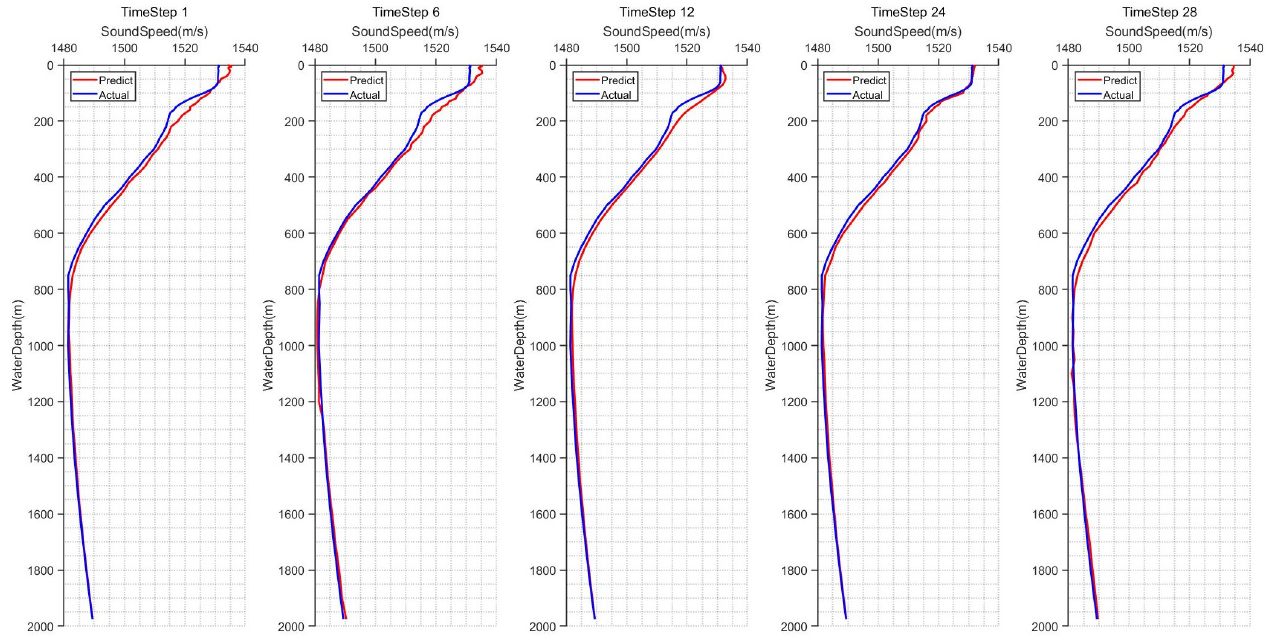
Figure 8. Prediction of different time steps.